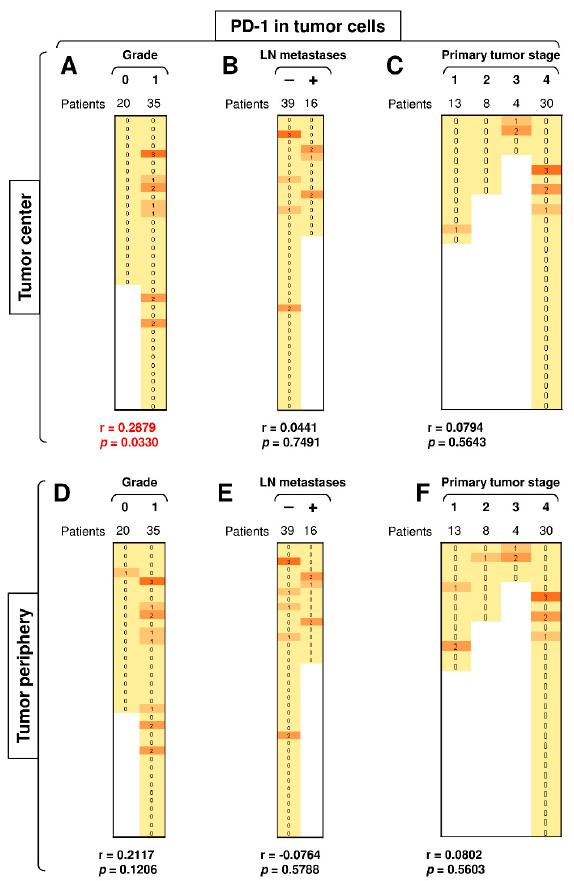
Figure 5. A high load of PD-1 + tumor cells in the tumor center correlates with tumor grade. ( A ) The co- hort of 55 SGC patients was stratified into 2 groups according to tumor grade (grade 0 and grade 1), and the Spearman correlation with the expression of PD-1 in tumor cells in the tumor center was determined. ( B ) The patient cohort in ( A ) was stratified into 2 groups according to the pres- ence ( + ) or absence ( – ) of LN metastases, and the Spearman correlation was determined as in ( A ). ( C ) The patient cohort in ( A ) was stratified into 4 groups according to the primary tumor stage, and the Spearman correlation was determined as in ( A ). ( D – F ) The cohort of 55 SGC patients was stratified into groups as in ( A – C ), and the Spearman correlation with the expression of PD-1 in tumor cells in the tumor periphery was determined. In ( A – F ), the correlations were evaluated by Spearman correlation tests, ( A – F ): n = 55. * p < 0.05 was considered significant. In ( A – F ), the expression analyses of PD-1 were performed according to the scoring system described in the Materials and Methods Section. The data are presented as a heat map with the scores. The color scale is presented as follows: yellow color: score 0; marigold color: score 1; ochre color: score 2; bronze color: score